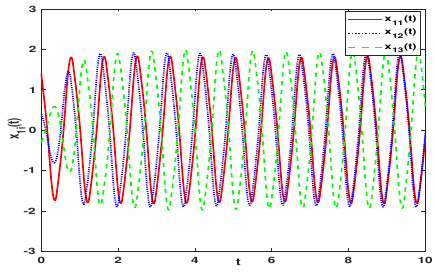
Figure 13. The chaotic masking signals x 1 i ( t ) .